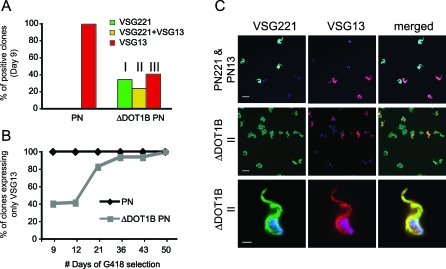
DOT1B is Required for Rapid Switching and for Monoallelic Expression(A) VSG expression of G418-resistant clones after 9 d of drug selection. Ten parental PN and 17 ΔDOT1B PN clones were analyzed by protein dot blot with anti-VSG221 and anti-VSG13 purified sera. The same analysis was repeated in three independent experiments, on an average of 15 G418-resistant clones.(B) Variation of VSG expression with time. The same clones described above were periodically analyzed by dot blot for a total of 50 d. The percentage of clones that are exclusively recognized by anti-VSG13 is plotted.(C) Non-cross-reactivity of anti-VSG221 and anti-VSG13 were tested by IFA on a 50:50 mixture of wild-type PN221 and PN13 cells (upper panels). The same sera and conditions were used for IFA of ΔDOT1B Class II clones (middle and bottom panels). DNA was detected with DAPI (blue). Scale bars: 10 μm (upper and medium panels), 2 μm (lower panel).